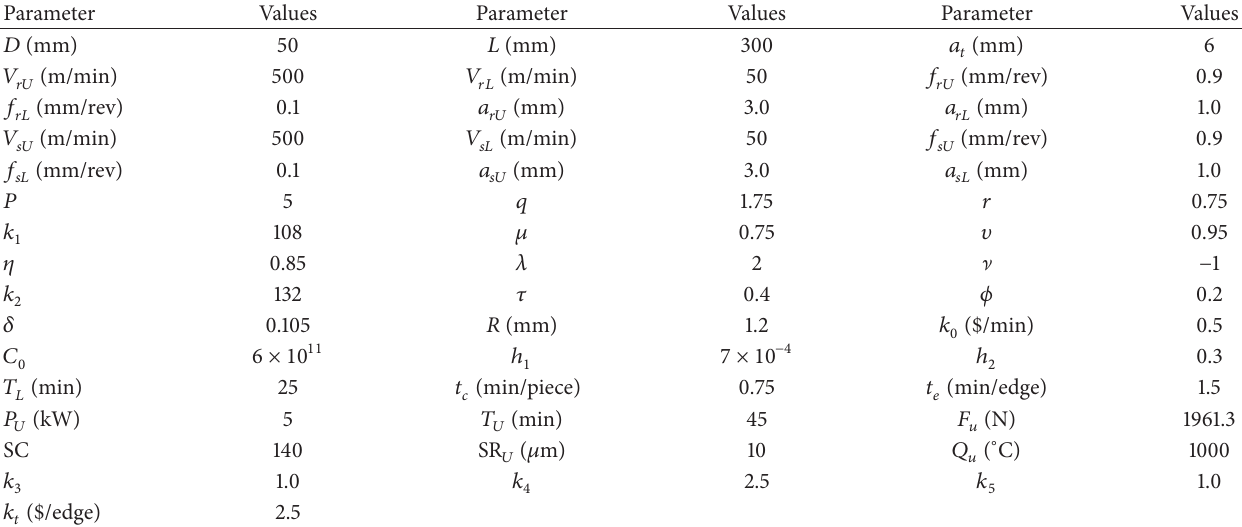
Table 1: Machining data [10].